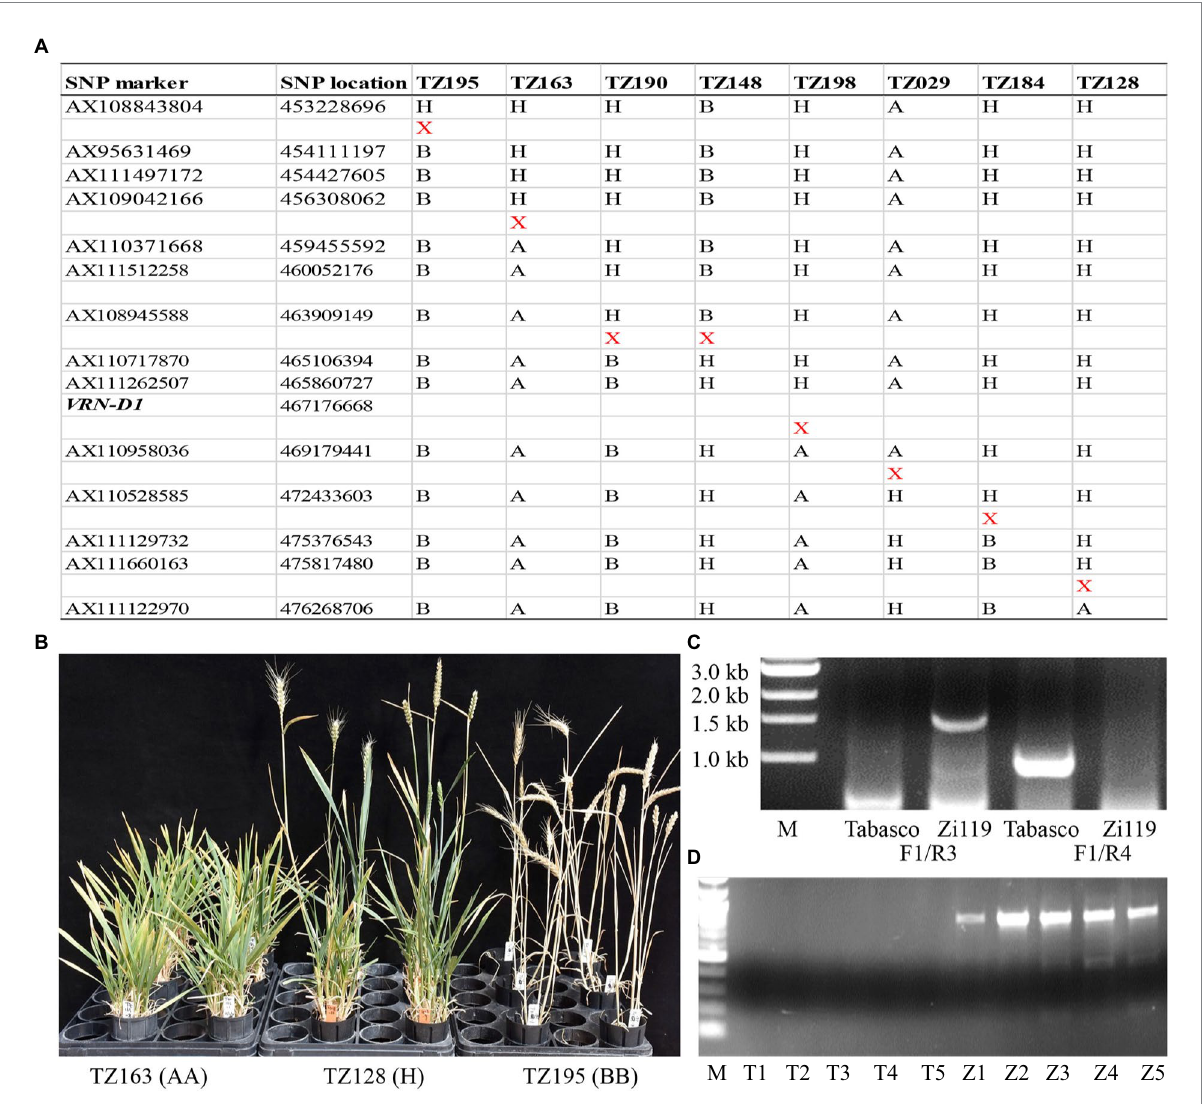
FIGURE 3 Genotypes and phenotypes of recombinant plants that have crossovers at the VRN-D1 locus. (A) Physical locations of eight crossovers that occurred at the VRN-D1 locus. “ X ” indicates a crossover detected between two neighboring markers. (B) Images for developmental processes in three recombinant lines in their respective F 3 populations. (C) The PCR marker for InDel between the Vrn-D1 allele in Zi119 and the vrn-D1 allele in Tabasco. (D) PCR products from cDNA samples from each of five random plants carrying the Vrn-D1 allele from Zi119 (Z1–Z5) and the vrn-D1 allele from Tabasco